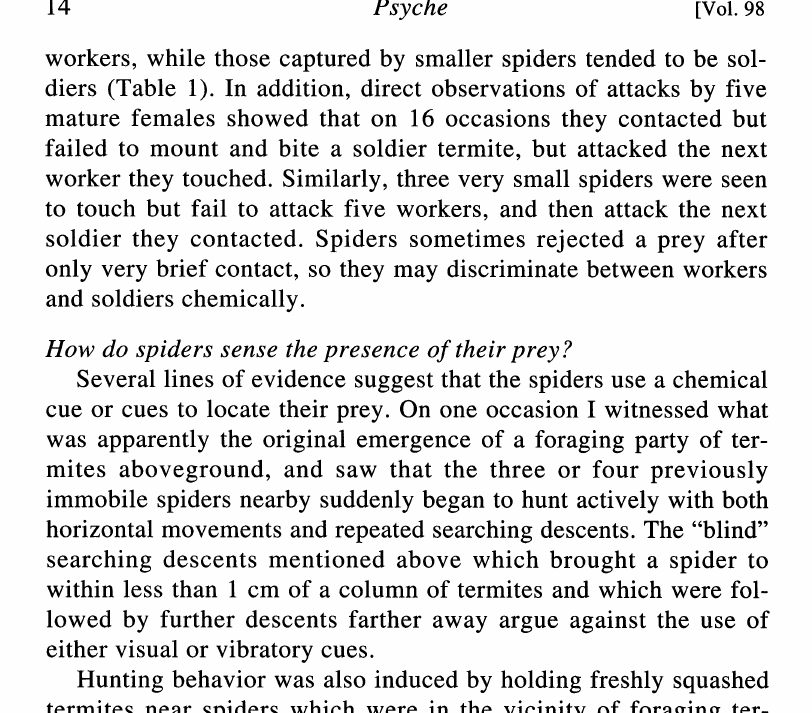
Table 1. Numbers of prey found in 1990 associated with different sized Chrosio- thes tonala spiders feeding in the field (differences are highly significant, p0.0001). Spider sizes were estimated in the field: "small" includes the first and possibly the second instars outside the egg sac; "large" includes penultimate nymphs and adult females. Numbers in parentheses are numbers of spiders.